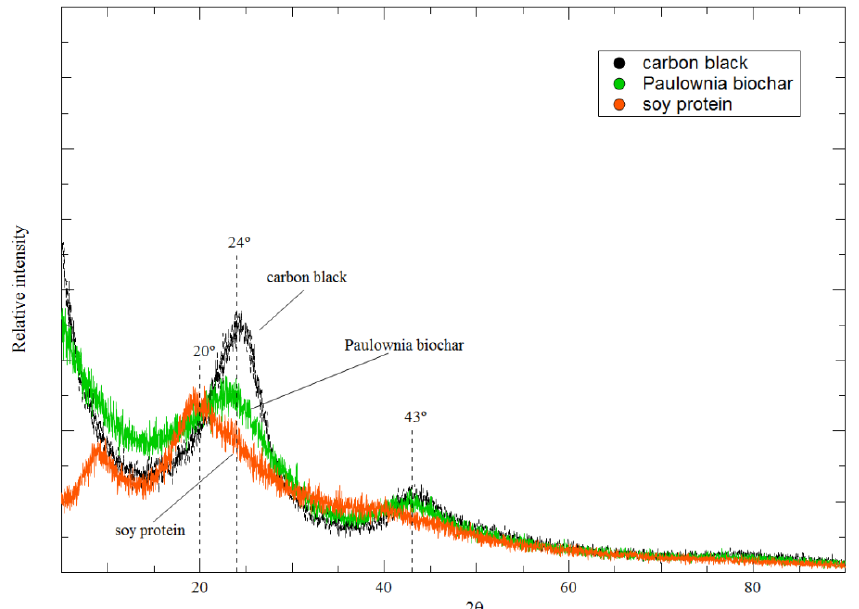
Figure 2. X-ray diffraction traces of the Paulownia biochar, carbon black, and soy protein. Graphitic d-spacing peaks typical of carbon black-type structure are visible at 24° and 43° 2θ, and the soy protein α-helix and β-sheet peaks at 10 and 20° 2θ are also visible. Table 2. SA-CC/soy protein ratio